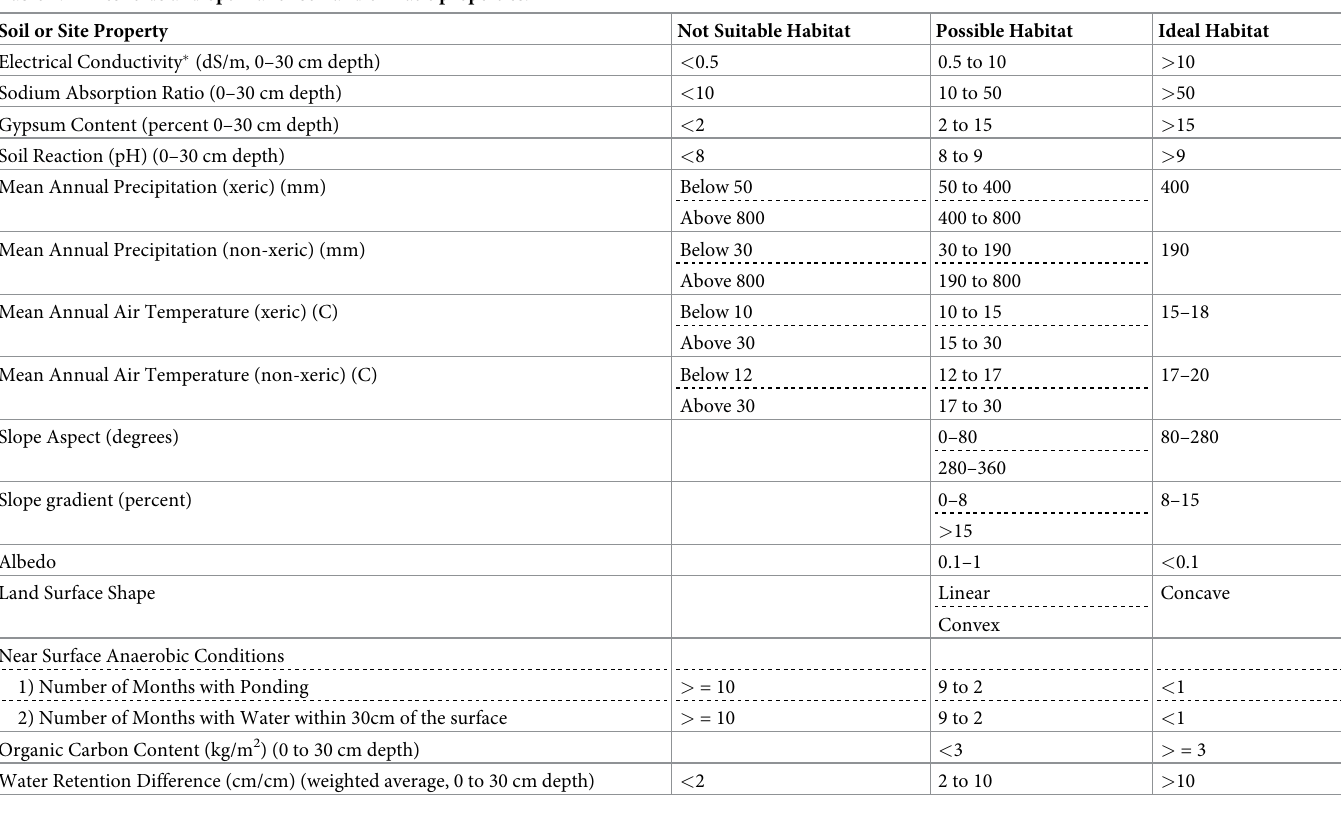
Table 1. Thresholds and optima for soil and climatic